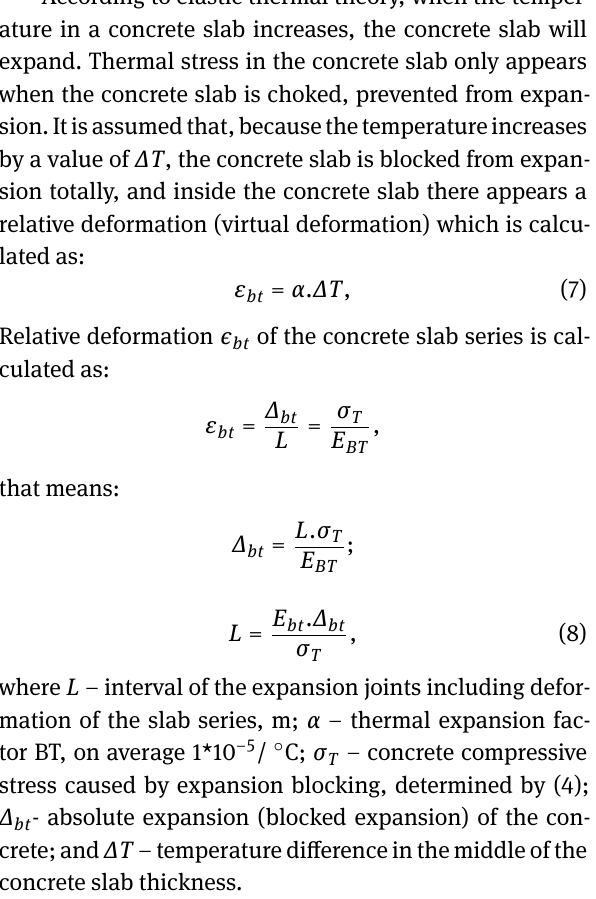
Figure 4: The model simulation of concrete slab coming up caused by thermal expansion without expansion joint